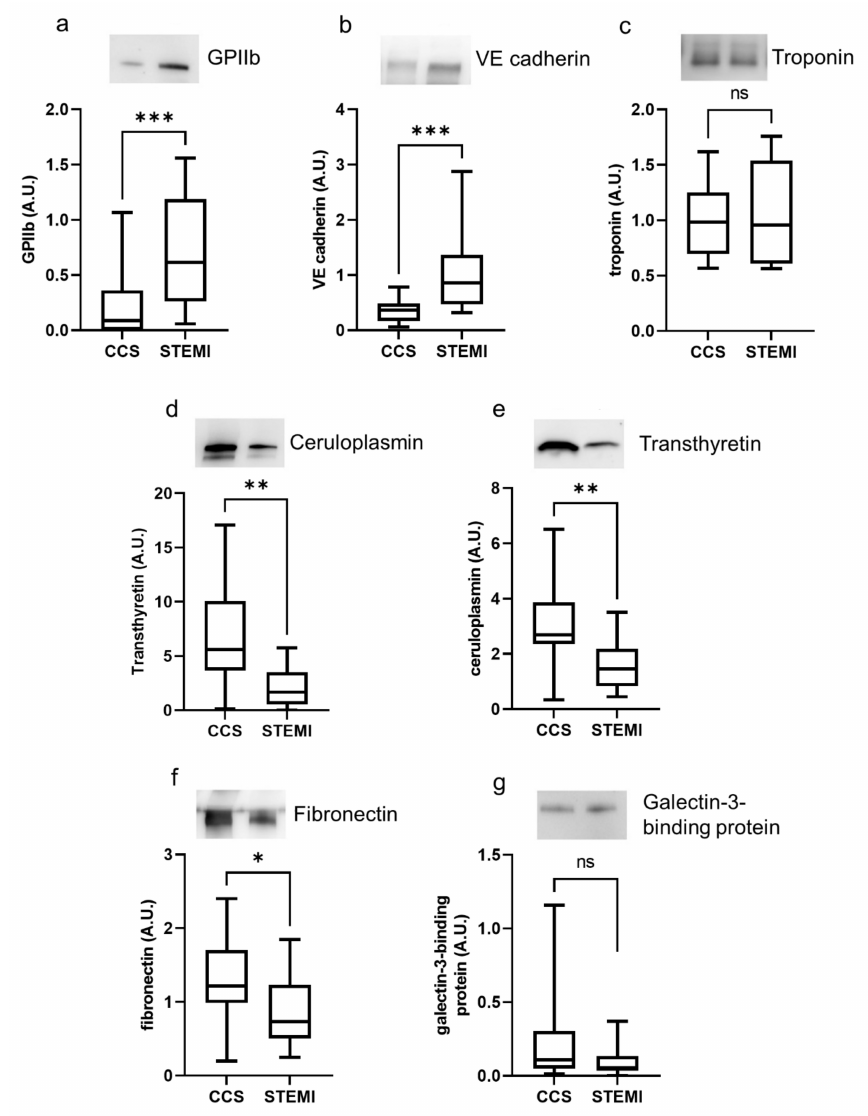
Figure 2. Plasma exosomes of STEMI patients display a different expression of specific proteins. Plasma exosomes from CCS and STEMI patients were lysed, and the expression of selected proteins was investigated. ( a – g ) Densitometric quantification and representative images of Western blot analysis of GPIIb ( a ), VE-cadherin ( b ), troponin ( c ), ceruloplasmin ( d ), transthyretin ( e ), fibronectin ( f ) and galectin-3-binding protein ( g ). For each box plot, the center line illustrates the median and box limits indicate the 25th and 75th percentiles. ns: not significant, * p < 0.05, ** p < 0.01, *** p <